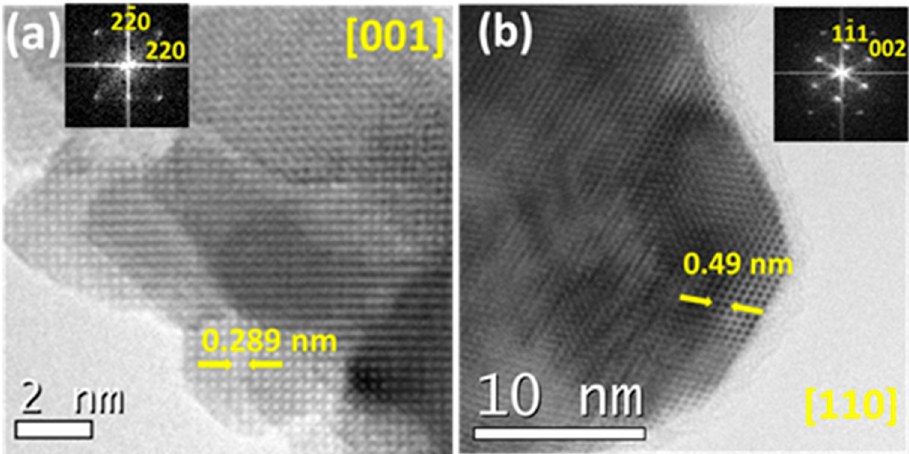
Figure 16. HRTEM images and the corresponding projections of representative nanocrystals of Co 3 O 4 sample along: ( a ) [001] and ( b ) [110] projections.